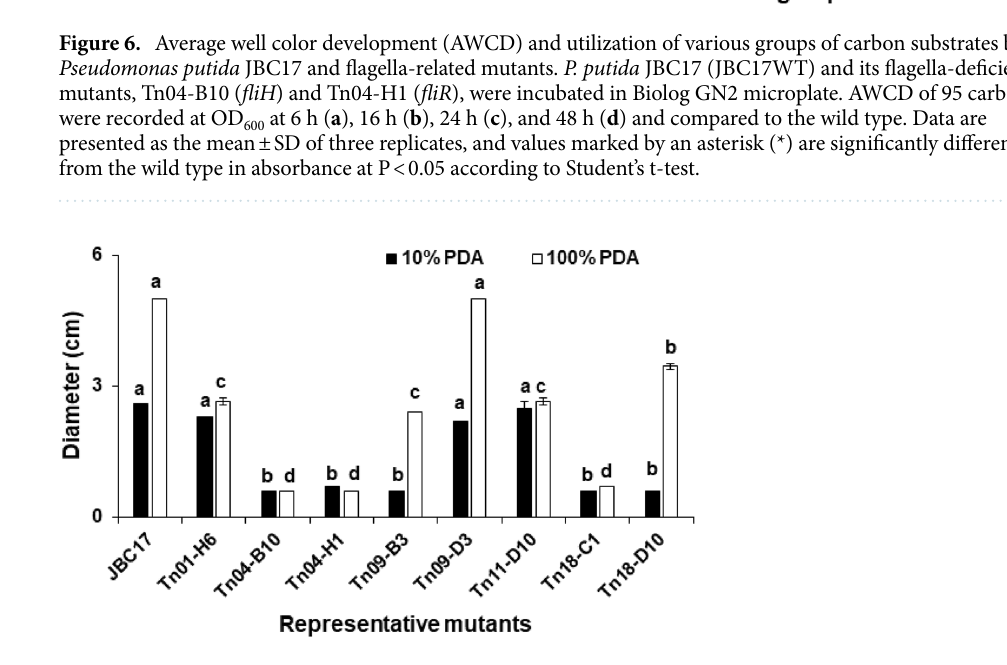
Tn04-H1 (Δ fliR ). The production and function of flagella are complex processes that require coordination in space and time 27 . The complementation of the mutated gene with the plasmid may not restore all the alterations induced by the mutation. Overall, complementation of the fliR gene marginally recovered swimming motility and growth rate, although it was still faster than the wild type. The results of the complementation assay indi-